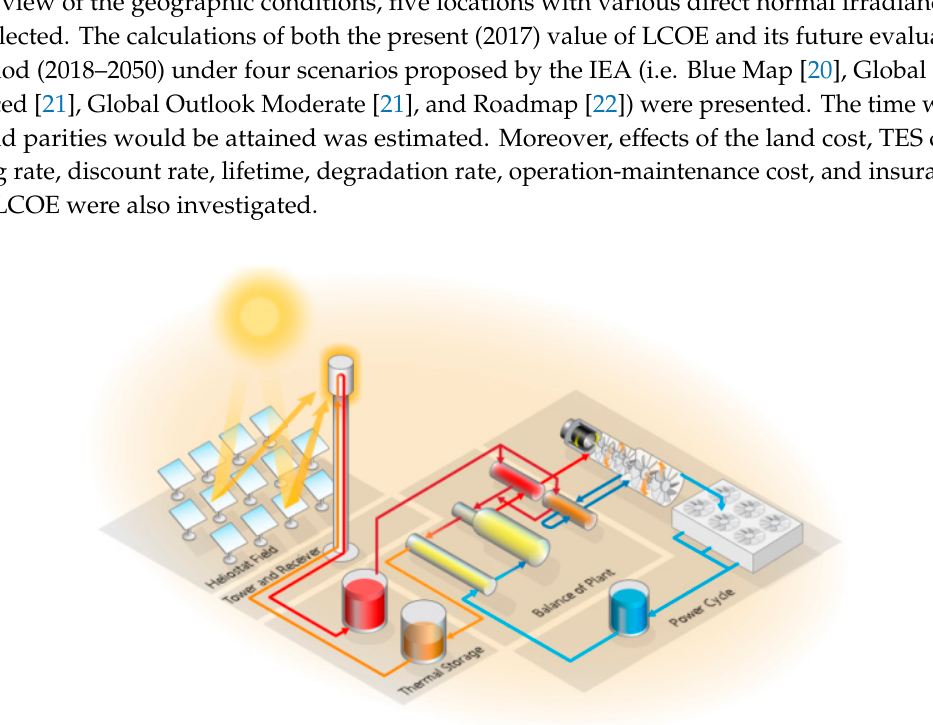
Figure 1. Operating principle of a typical tower concentrating solar power (CSP) plant [23].